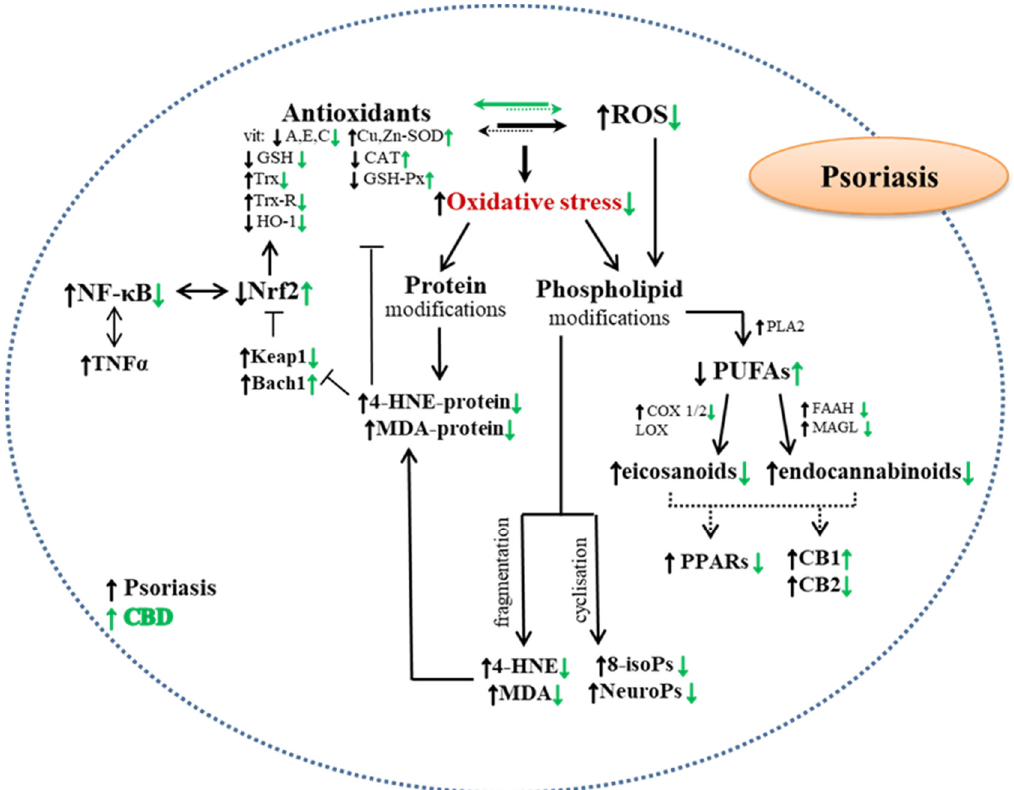
Figure 2. The effect of cannabidiol (CBD) on redox imbalance, inflammation and their metabolic consequences in the keratinocytes of patients with Psoriasis. Abbreviations: